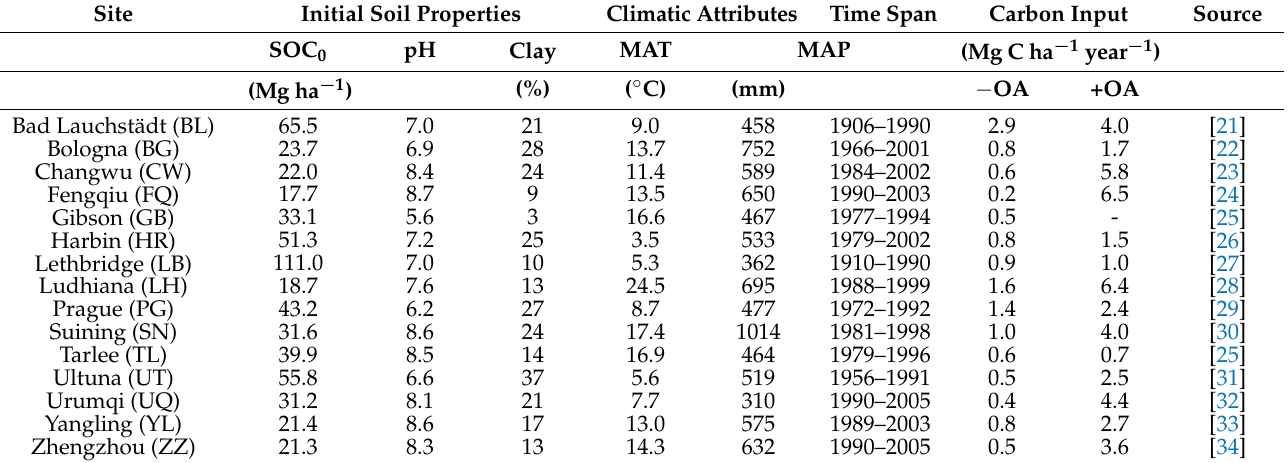
Table 1. Summary of soil, climate, and experimental information at each study site. Site Initial Soil